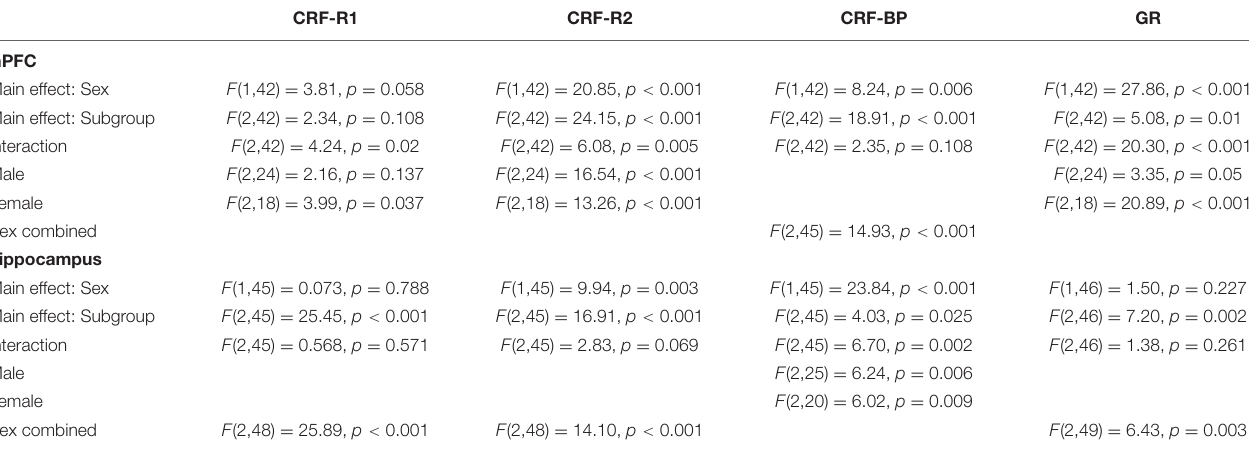
TABLE 2 | ANOVAs for Western Blot analyses. CRF-R1 CRF-R2 CRF-BP GR